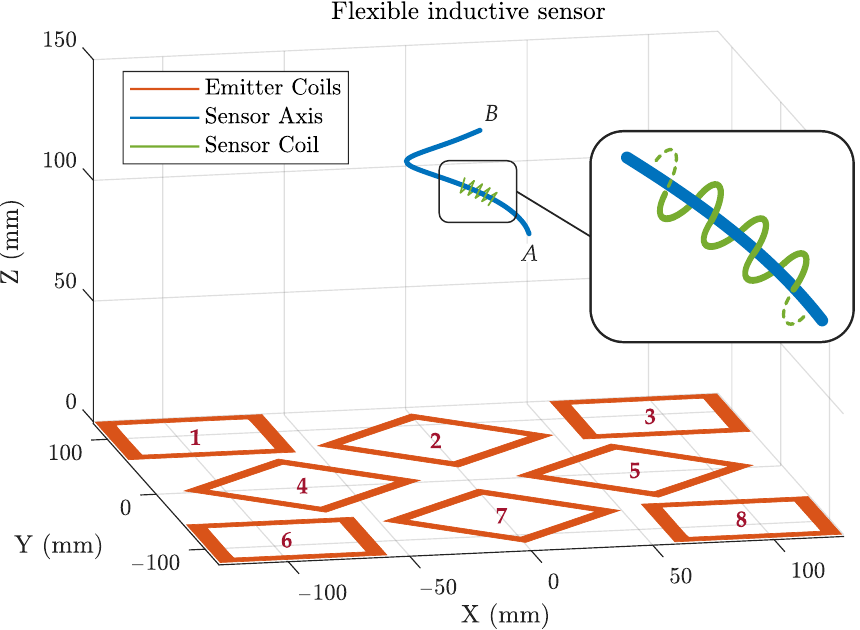
Figure 4. A simulated EMT test was performed on a 128mm-long flexible sensor wrapped in a loop of radius 25mm, ranging from 100 to 150mm above the field generator. The inset shows an enlarge- ment of the inductive coil, which is wound around the sensor axis, coloured in